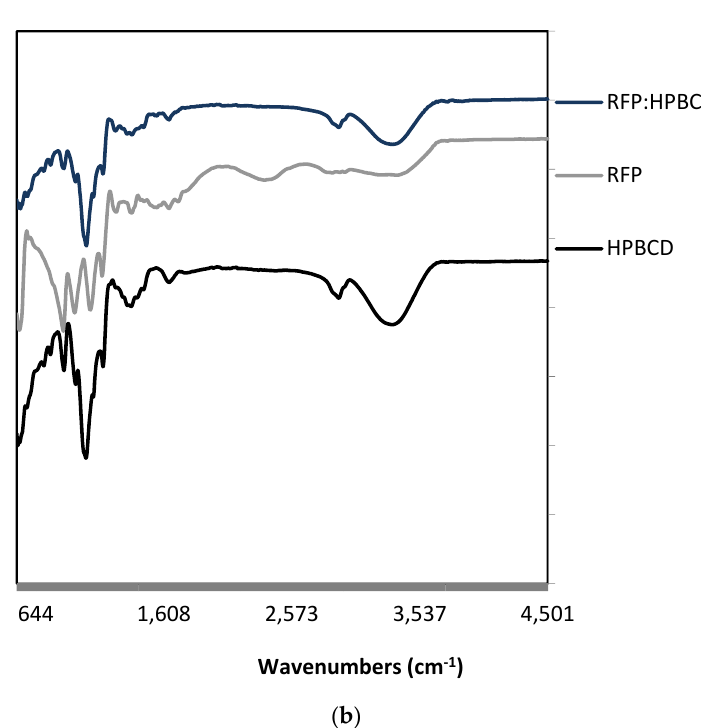
Figure 3. Differential scanning calorimetry ( a ) and infrared spectra results ( b ) of lyophilized solution samples from solubility profile assay.